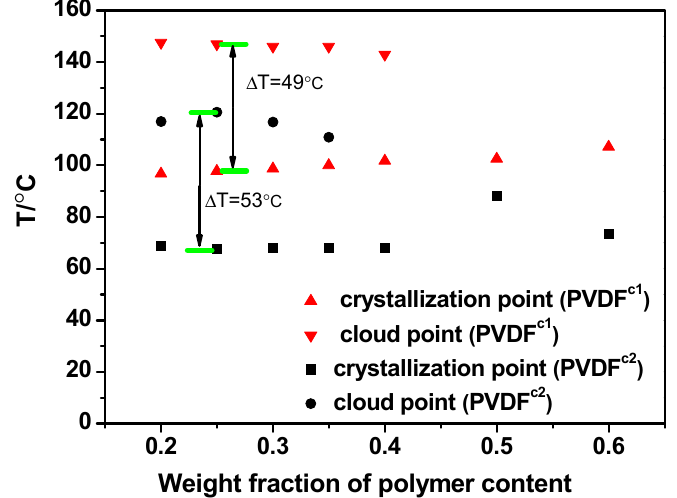
Figure 5. Phase diagram for PVDF copolymer/MS